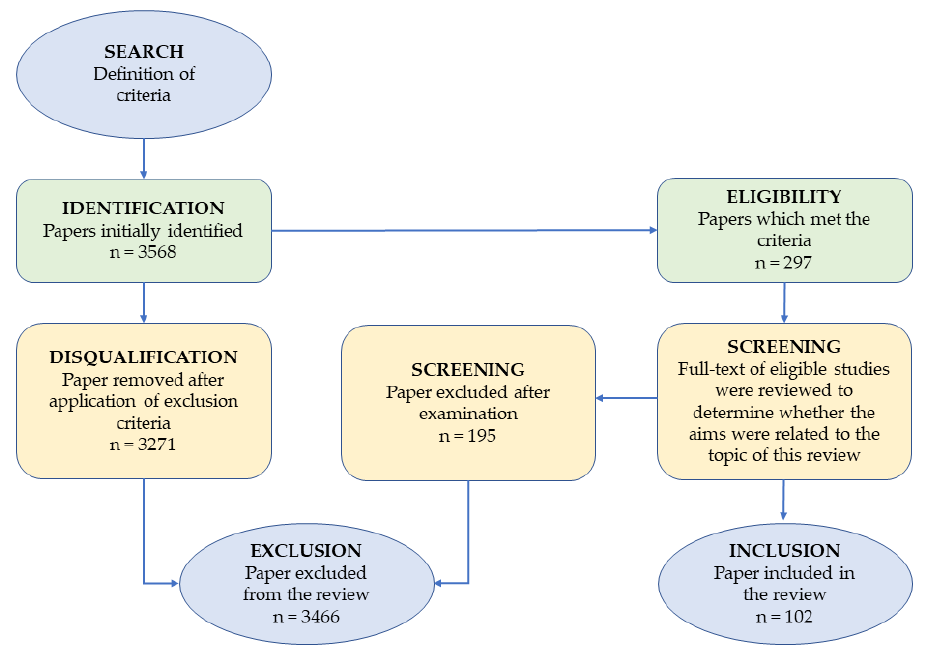
Figure 1. Flow diagram of study selection